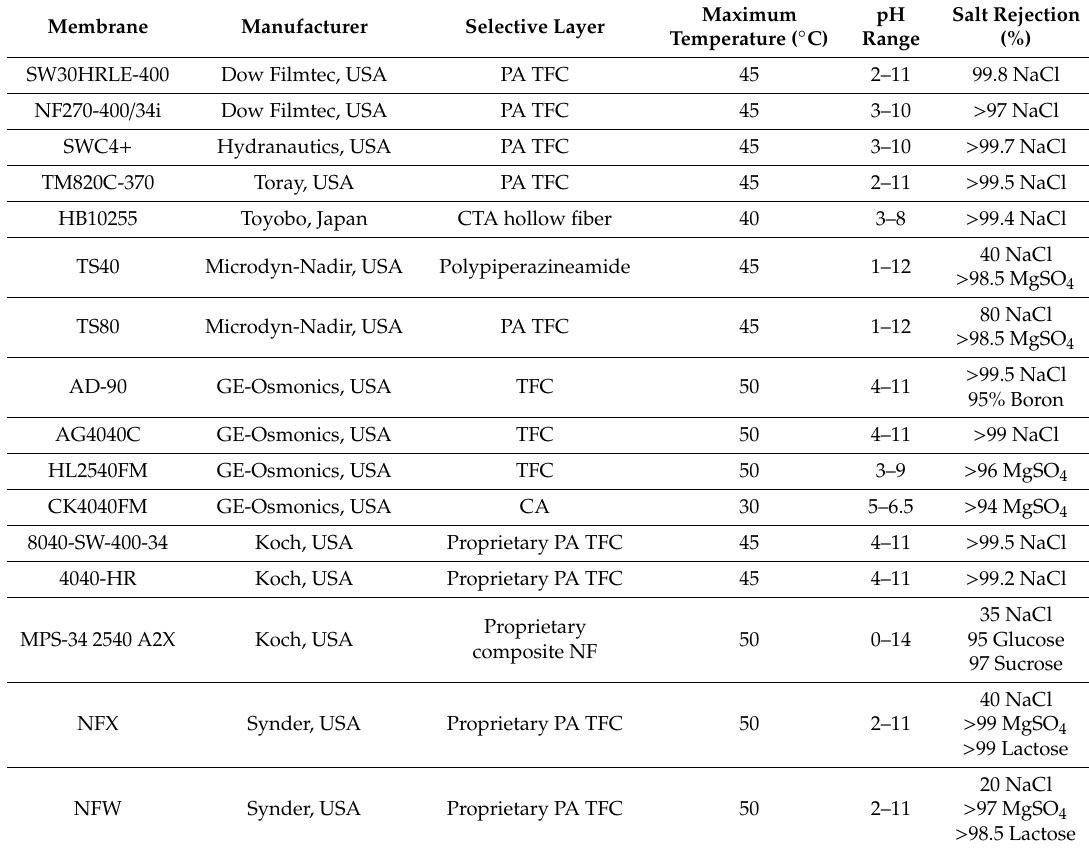
Table 1. Commercial polymeric RO and NF membranes for water